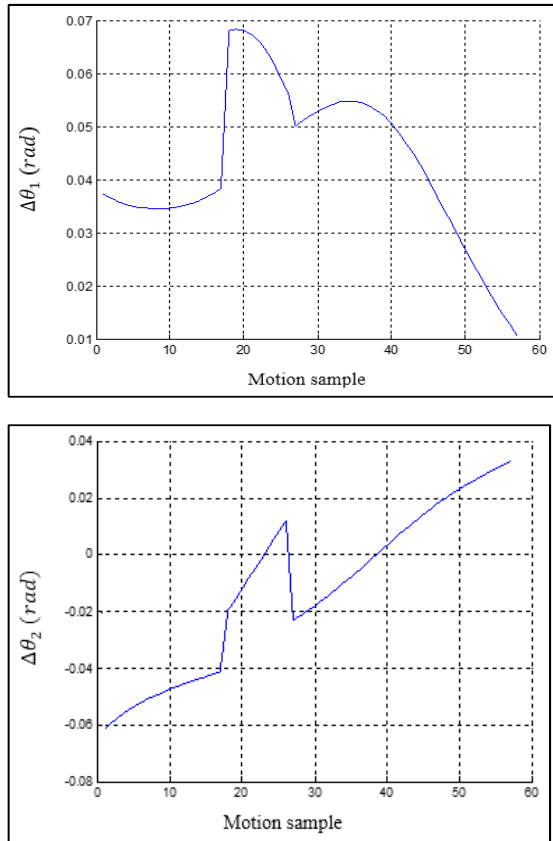
Fig. 11. The change in first and second angles of the two-link robot arm result for the D*